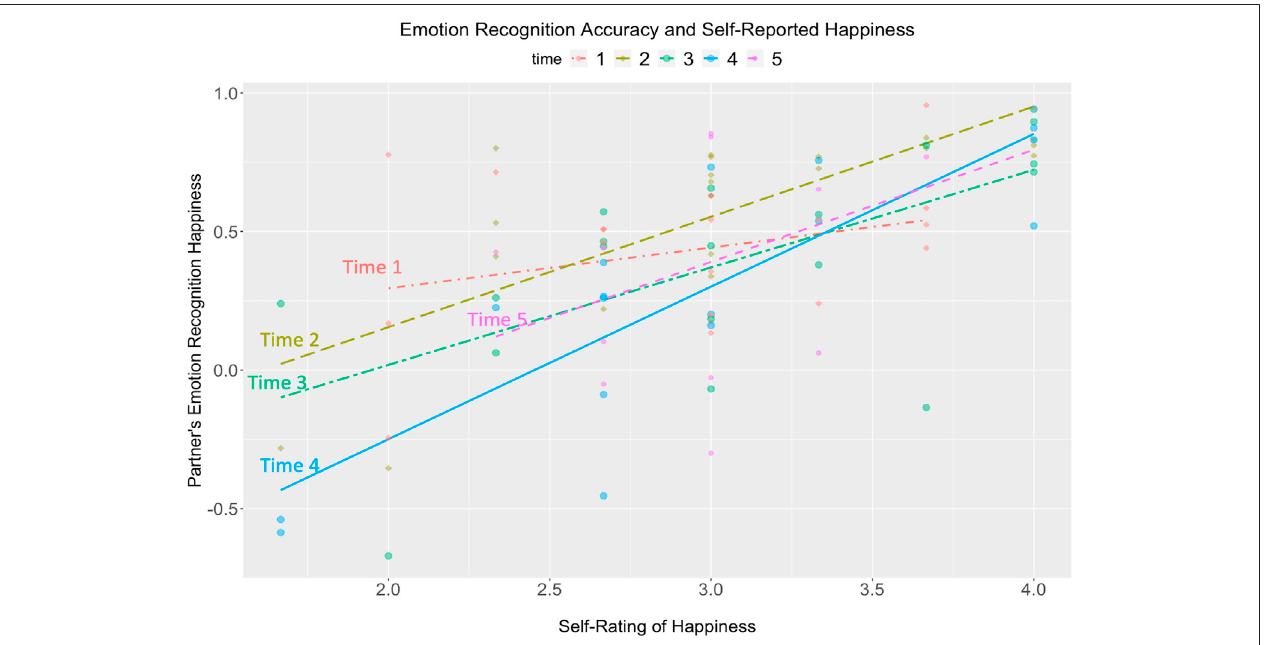
FIGURE6| Accuracyofemotionrecognitionpositivelycorrelatedwithself-reportedhappiness.Forthisplot,itemswerereverse-codedtomakeiteasiertointerpret (1: De fi nitely not to 4: De fi nitely). Y axis show correlation rates.